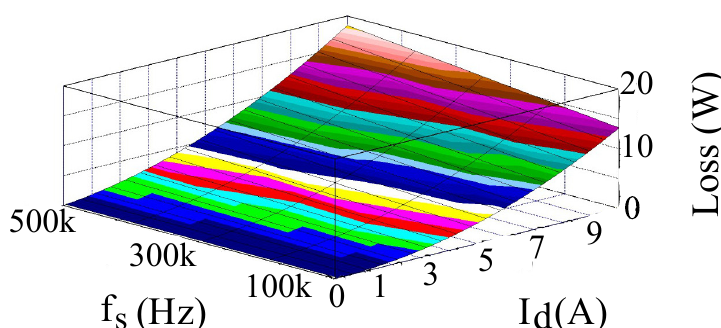
Figure 10. Behavior of switching and conduction losses in MOSFET IRFP460.